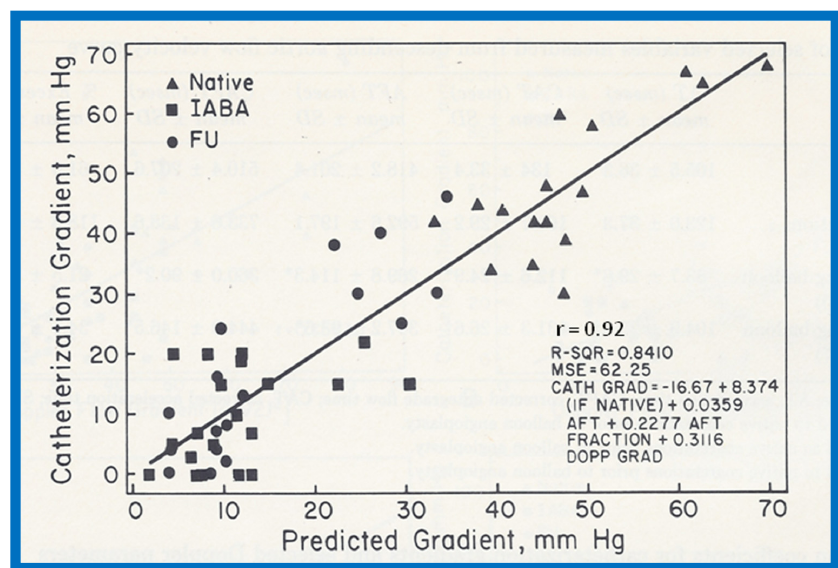
Figure 57. Linear regression analysis of catheterization-measured peak-to-peak gradients across aortic coarctation and predicted gradient calculated by the formula shown in the text indicated a better correlation ( r = 0.92). Filled triangles: Native coarctations; Filled squares: coarctations immediately after balloon angioplasty (IABA); Filled circles: coarctations at follow-up (FU). Reproduced from Rao P.S., Carey P. [18].